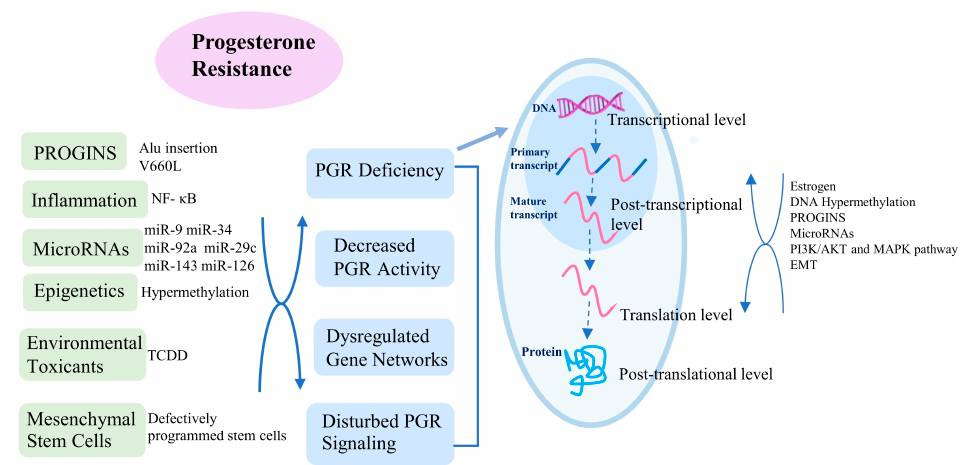
Figure 2. Putative mechanisms of progesterone resistance. Several overlapping but distinct mecha- nisms are responsible for progesterone resistance. PGR deficiency is considered the most significant mechanism; PGR can be suppressed at several levels in endometriosis.